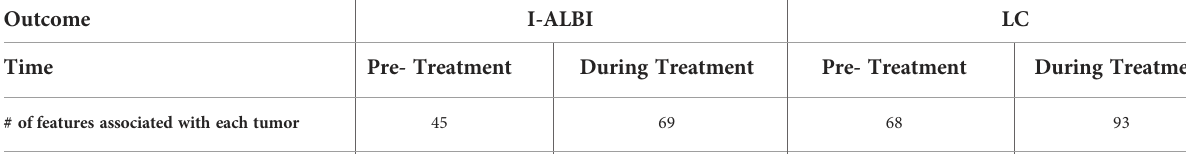
TABLE 2 The number of features associated with each of 104 tumors before and during treatment for I-ALBI or LC prediction.